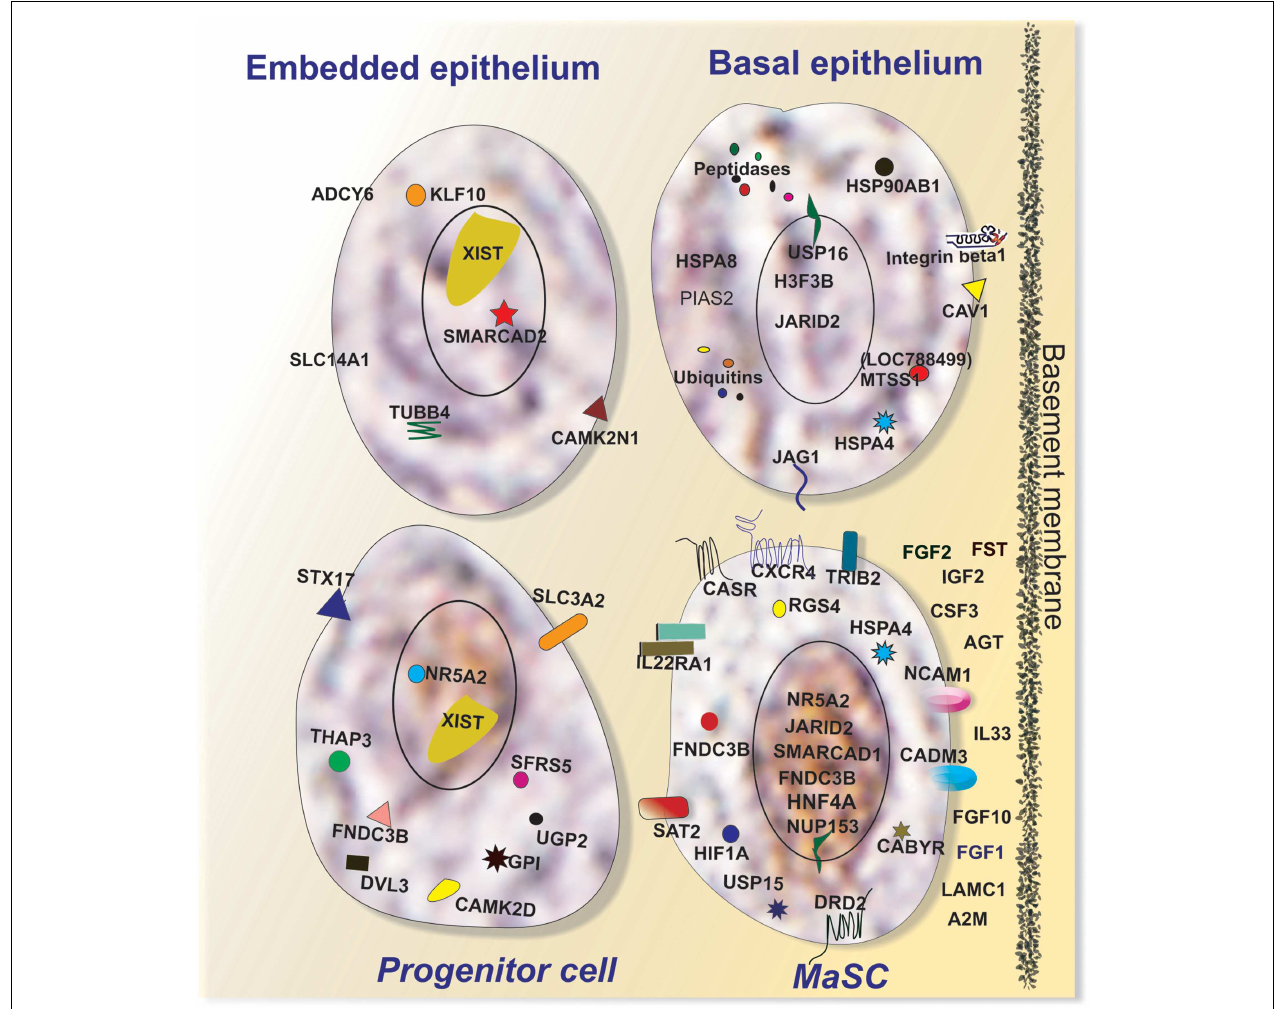
potential MaSC biomarkers including HNF4A and the pluripotency marker, NR5A2. Putative progenitor cells (LRECe) also express NR5A2 but at a reduced level along with increased expression of differentiation factors including XIST. Key features of control cells (non-LREC) in the basal and embedded epithelial layers are also